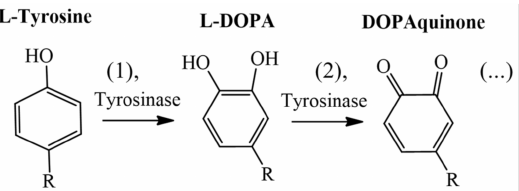
Figure 1. Catalytic stages (1 and 2) performed by tyrosinase in the biosynthetic pathway of melanin.